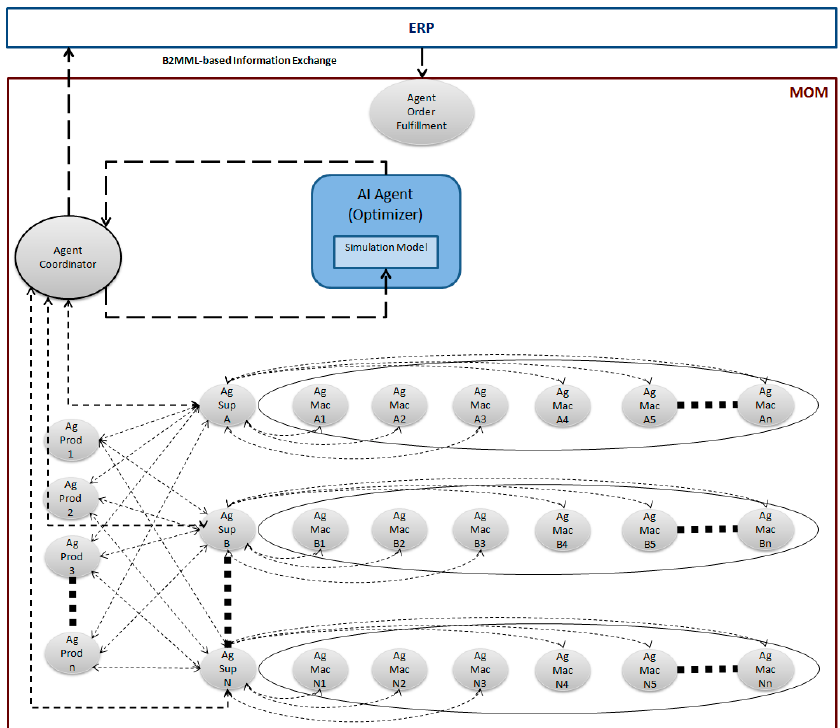
Figure 3. Novel framework for dynamically dealing with the JSP in CPSs.